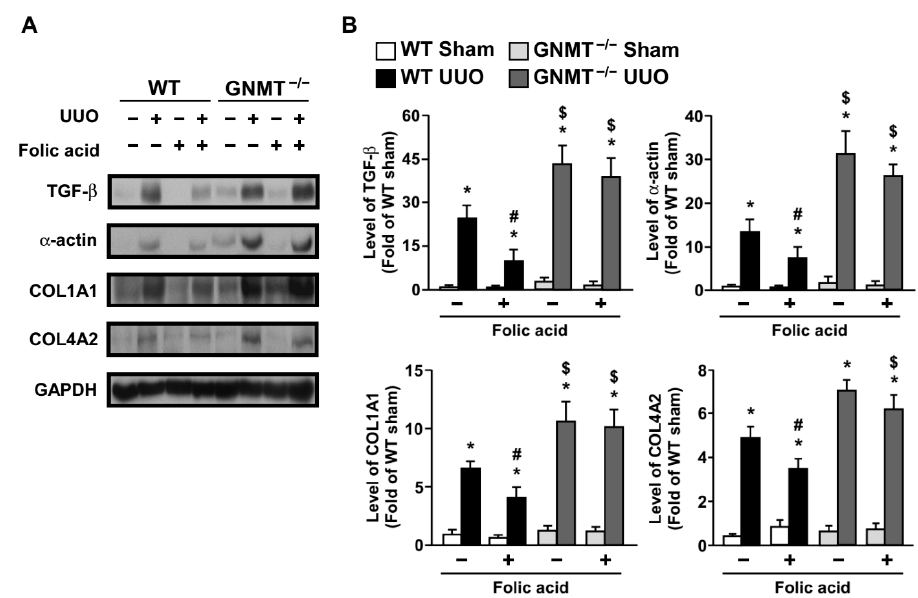
Figure 6. Effect of folic acid on UUO-induced expression of fibrosis-related proteins in WT and GNMT − / − mice. ( A , B ) Tissue extracts from kidneys were analyzed by immunoblotting with antibod- ies against the fibrosis-related proteins TGF- β , α -SMA, COL1A1, and COL4A2; GAPDH was used as a loading control. * p < 0.05 versus the sham group, # p < 0.05 versus non-folic acid-treated mice, $ p < 0.05 versus WT mice.